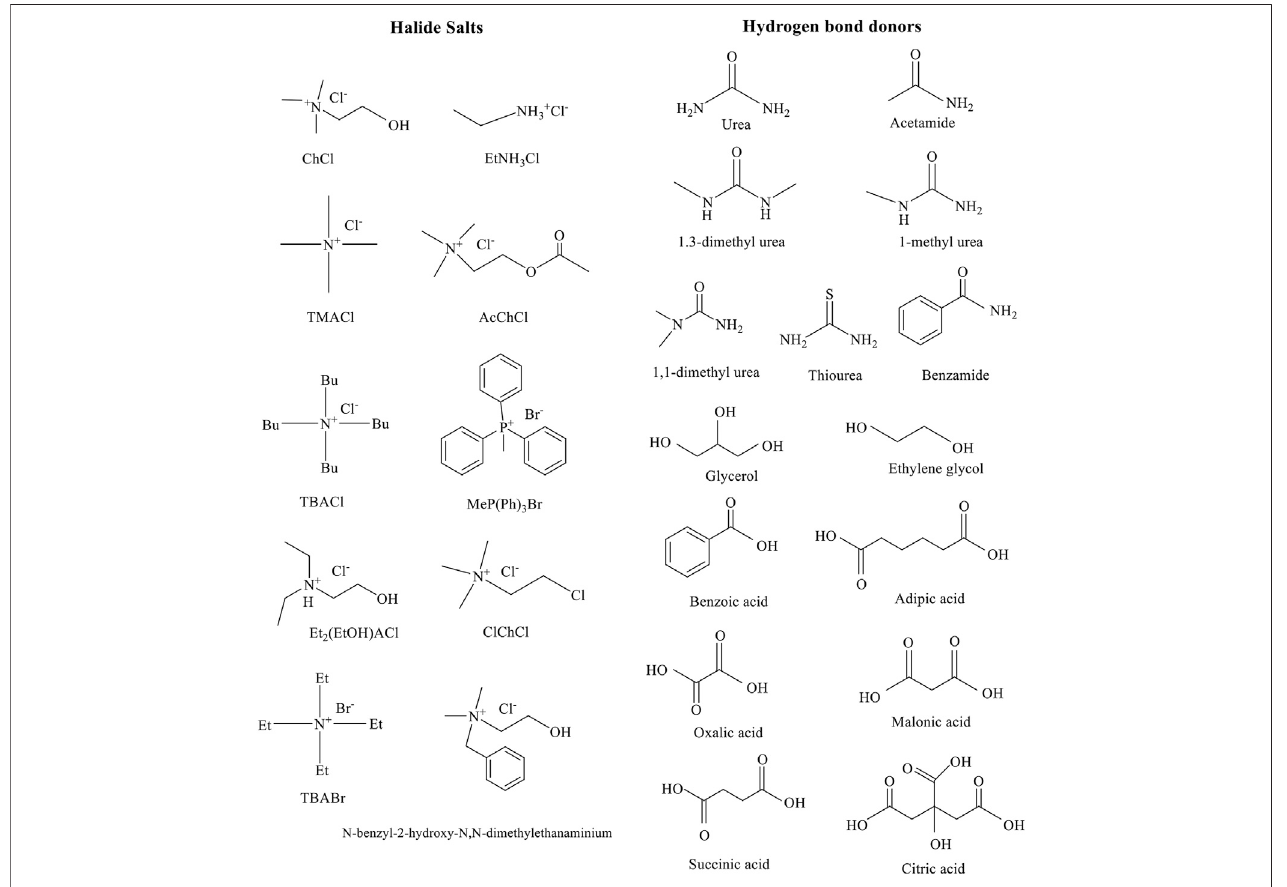
FIGURE6| Common structuresofhydrogen bonddonors and halidesalts are utilizedin theformationofDESs. Adapted with permission from Zhang etal. (2012).